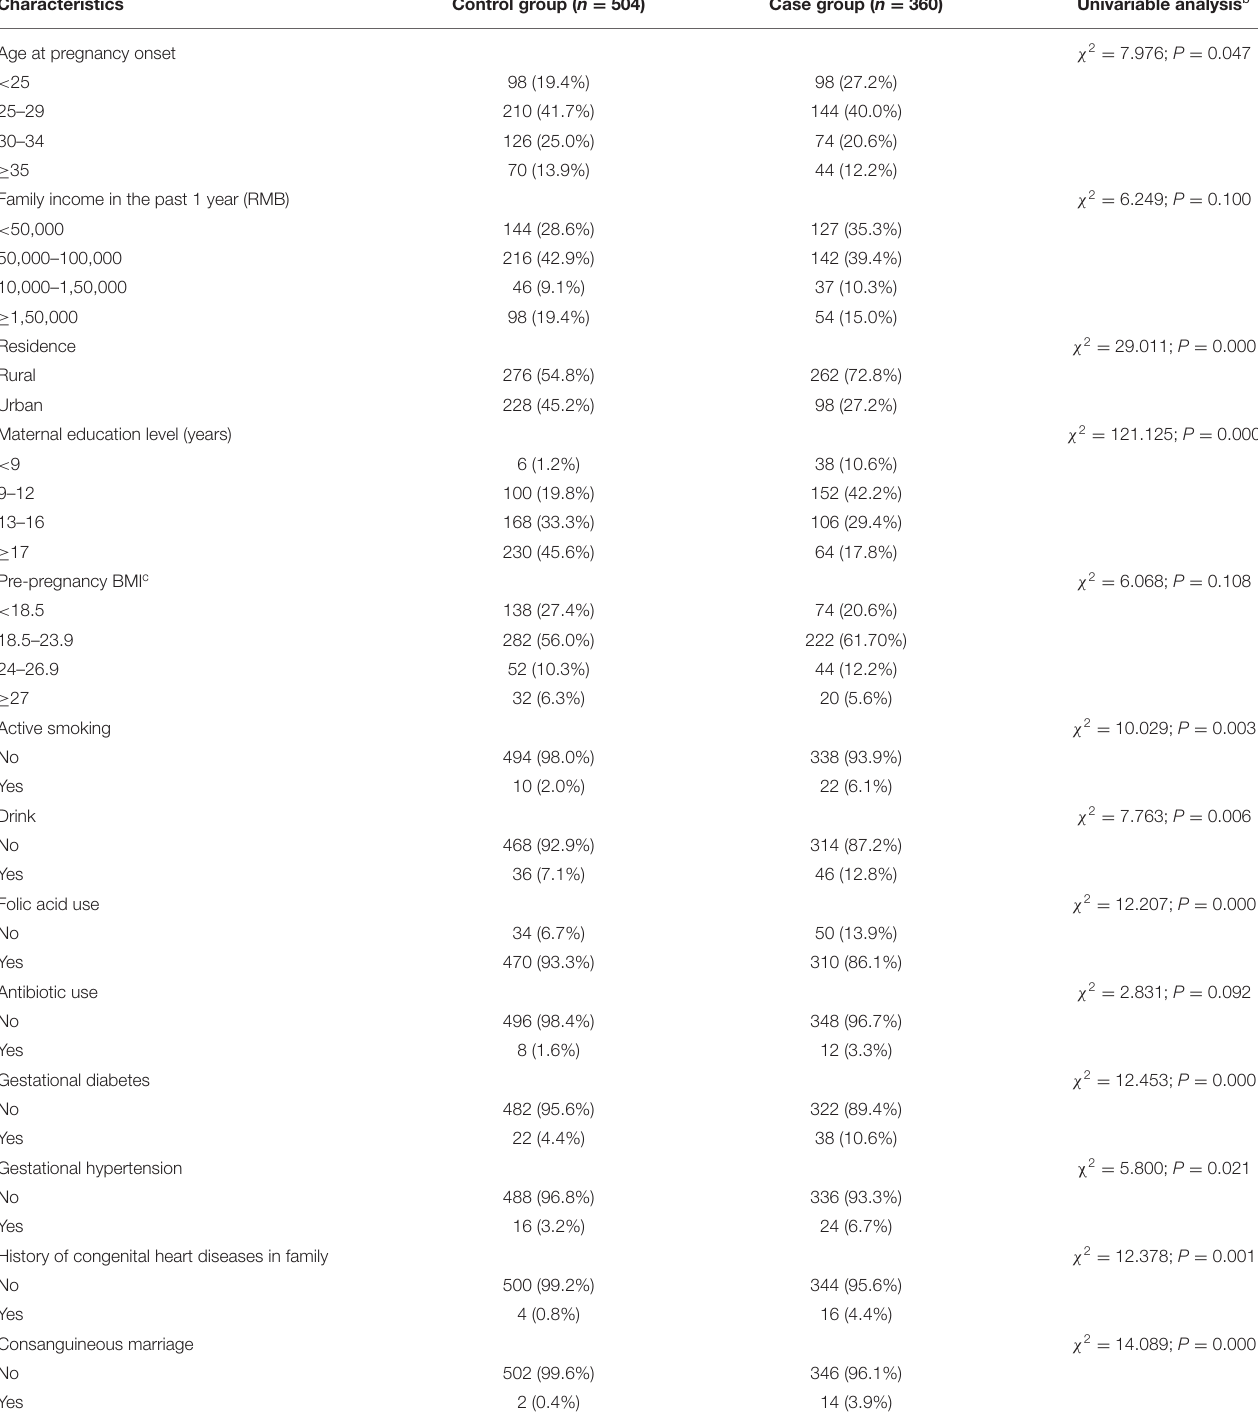
TABLE 1 | Baseline characteristics in case and control groups a